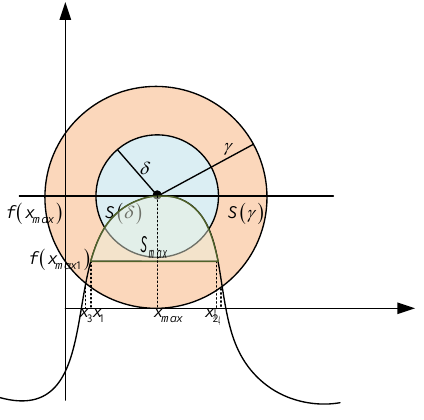
Figure 3. Stability of the MOJS algorithm in the Lyapunov meaning.